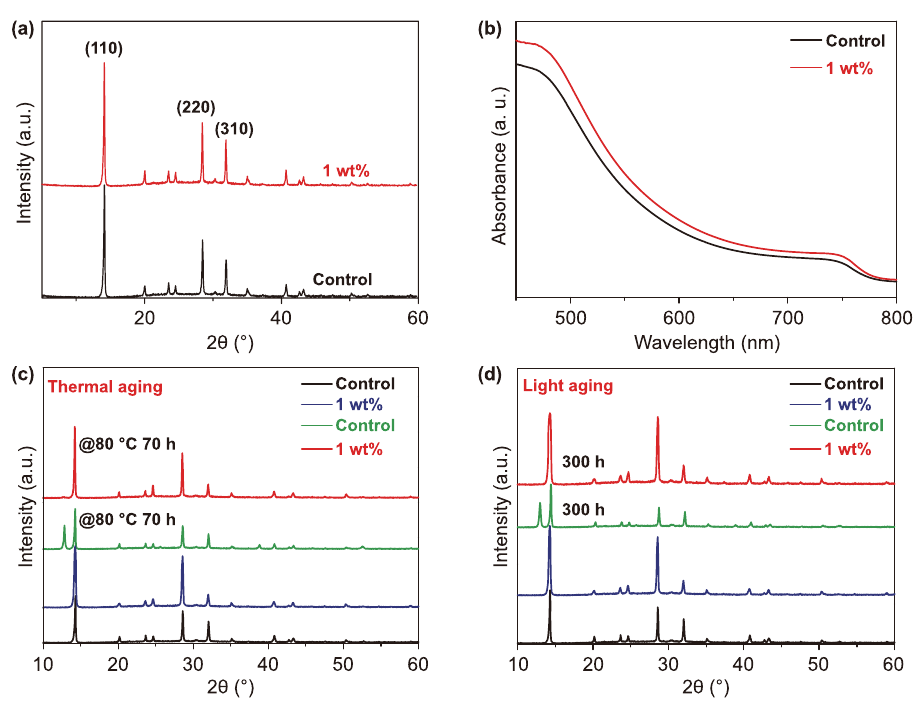
Fig. 3 a XRD spectra, b UV–Vis absorption spectra of the MAPbI 3 films with and without PEA. c XRD spectra of the MAPbI 3 films with and without PEA, before and after thermal aging at 80 °C for 70 h, and d light aging for 300 h